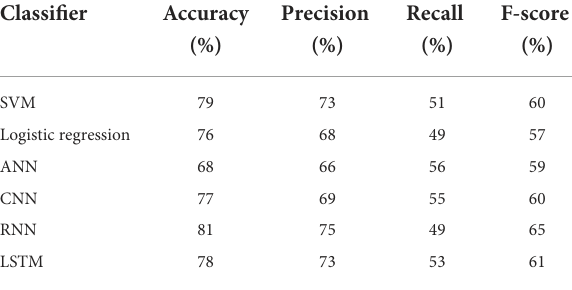
TABLE 2 Performance evaluation of SVM, logistic regression, ANN, CNN, RNN, and LSTM for given dataset.